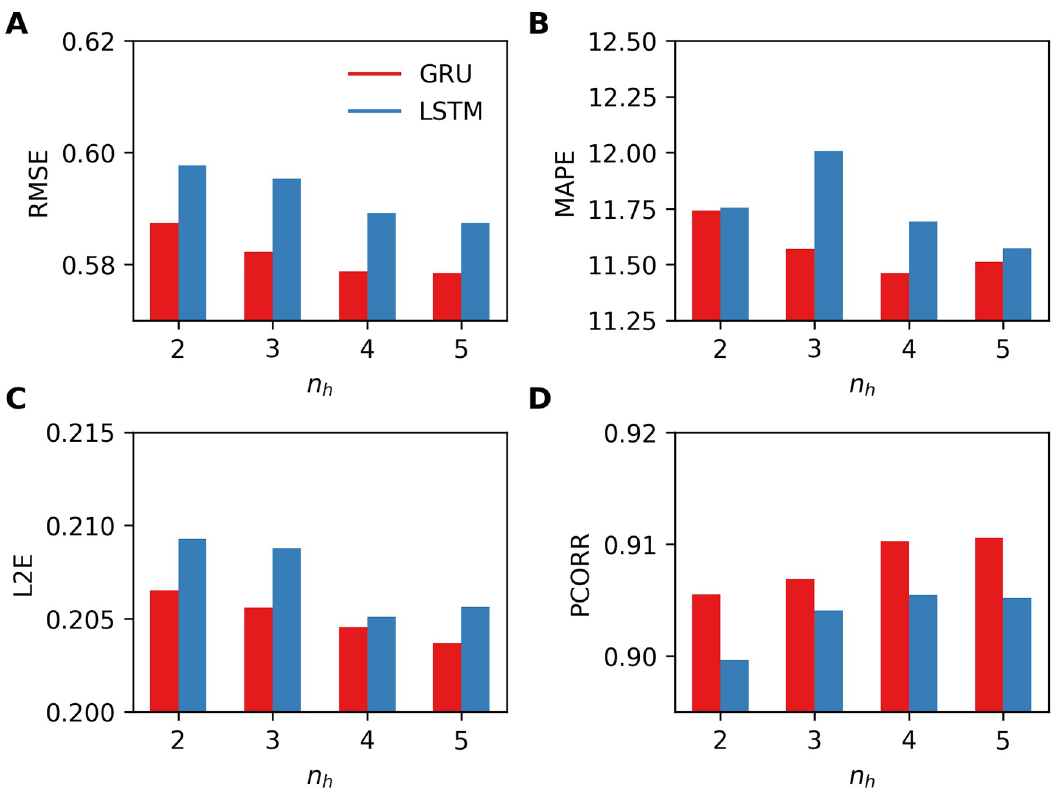
Fig 7. Four performance metrics for one-week-ahead predictions obtained by using RNN-LSTM and RNN-GRU for varying number of layers n = {2, 3, 4, 5}. A. RMSE, B. MAPE, C. L2E, and D. PCORR. Smaller values are preferable for RMSE, MAPE, L2E, h and larger values are preferable for PCORR.